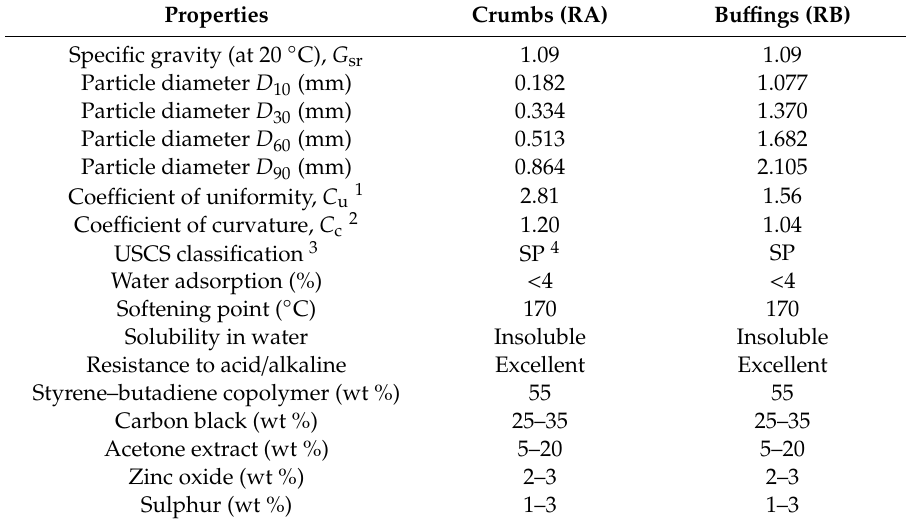
Table 3. Physical properties and chemical composition of the recycled tire